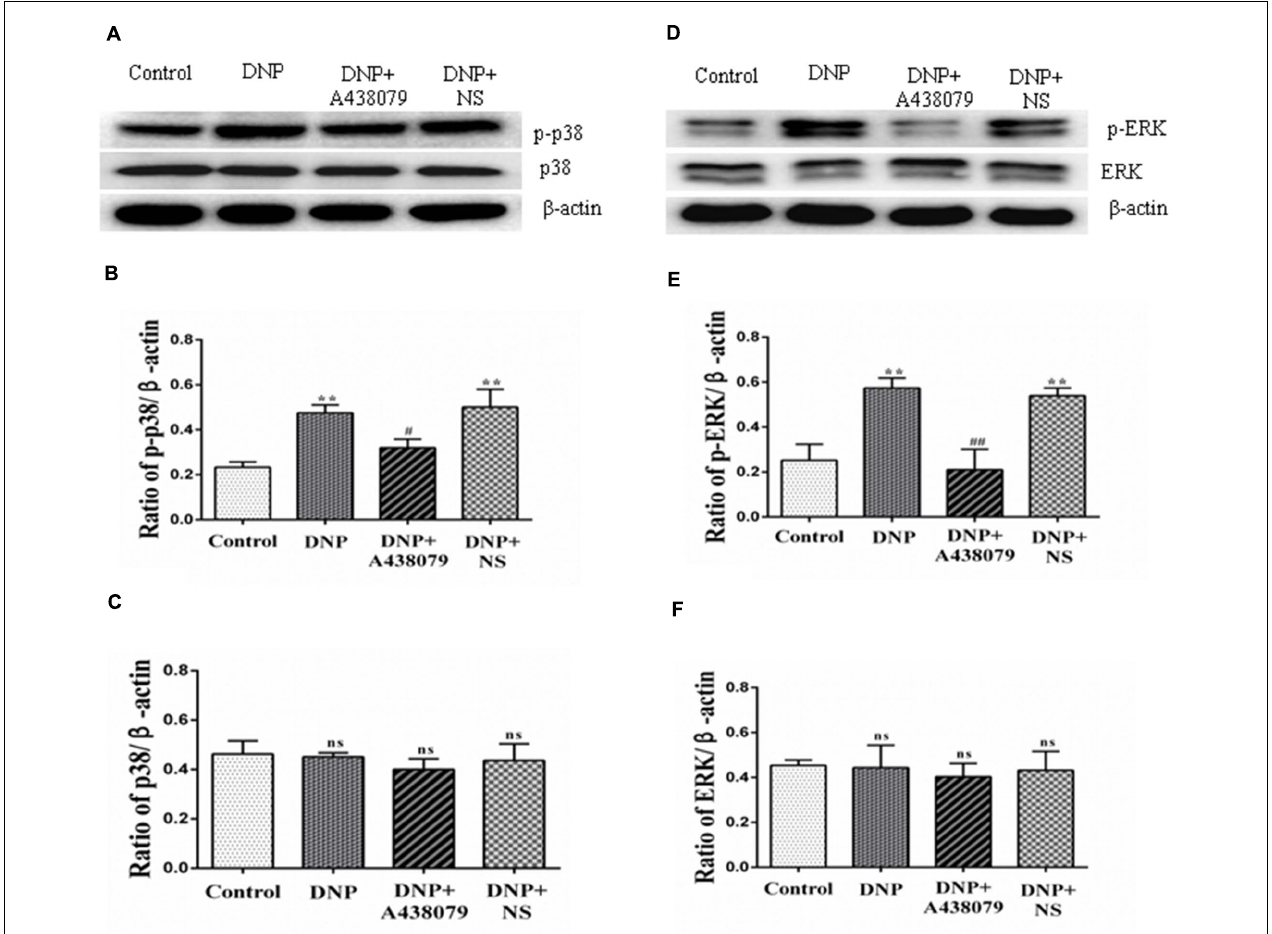
FIGURE 5 | Western blotting was performed to detect the levels of proteins related to the p38 and ERK1/2 signaling pathways in the DRG. (A) SDS-PAGE bands of the p-p38 and p38 proteins in each group. (B) The ratio of the optical density of p-p38 to that of the internal reference. (C) The ratio of the optical density of p38 to that of the internal reference. (D) SDS-PAGE bands of p-ERK1/2 and ERK1/2 in each group. (E) The ratio of the optical density of p-ERK1/2 to that of the internal reference. (F) The ratio of the optical density of ERK1/2 to that of the internal reference. The data are presented as the mean ± SEM, n = 6; compared with the control group, ** P < 0.01; compared with the DNP group, # P < 0.05, ## P < 0.01; ns indicates a non-significant